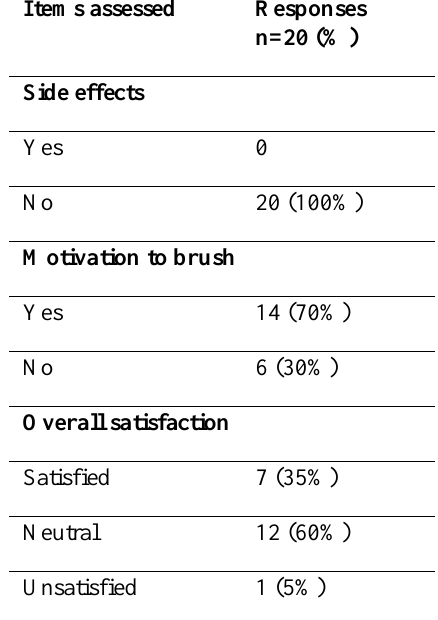
Table 4 : Experimental group’s feedback on dye containing tooth